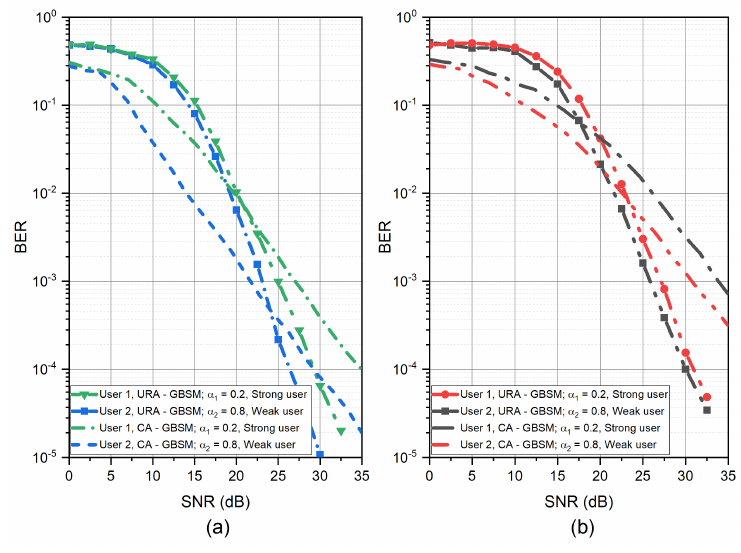
Figure 8. BER comparison of AF and DF schemes with ( a ) DF and ( b ) AF coding schemes. Table 3. Comparison of average BER with prior